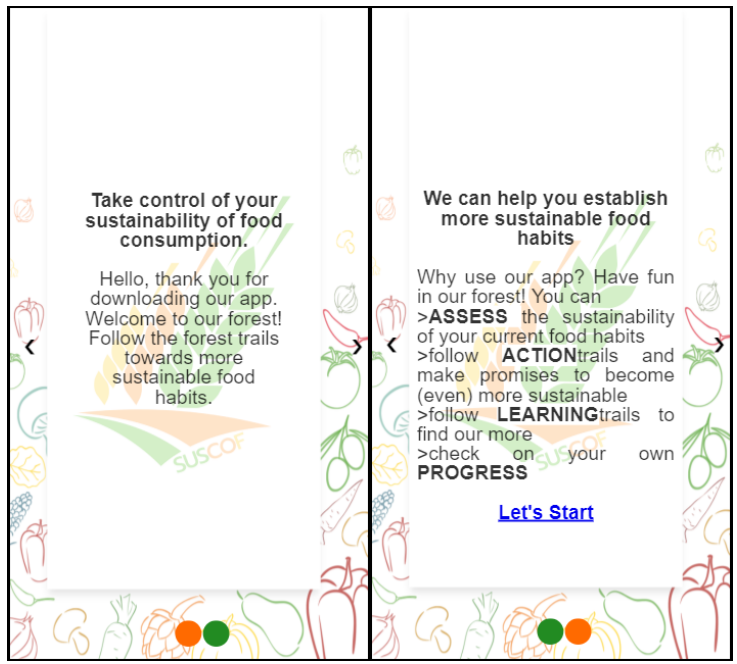
Figure 3. Information Page.